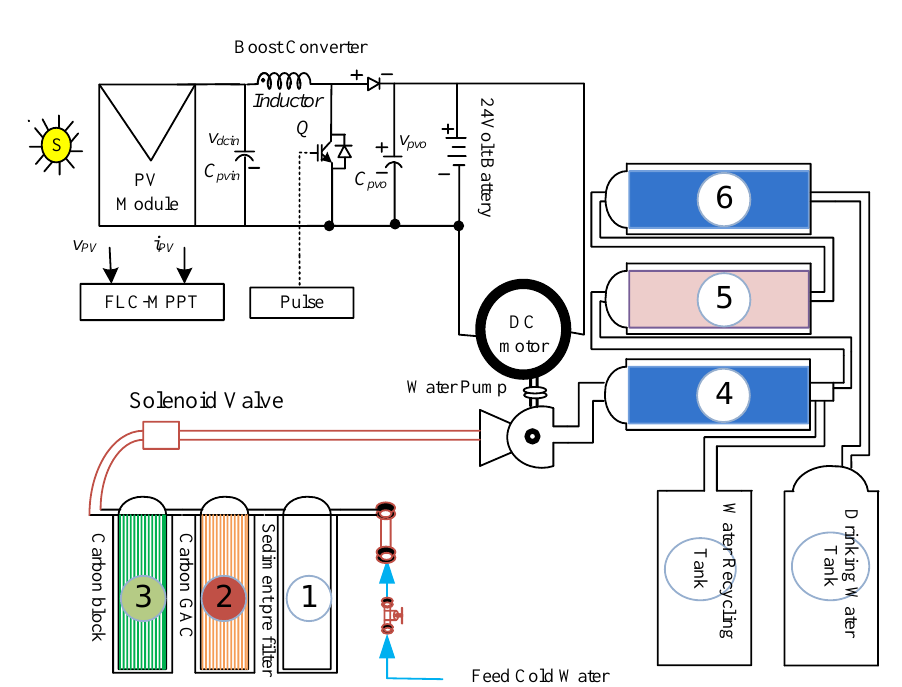
Figure 1. An overview of hardware model with its major